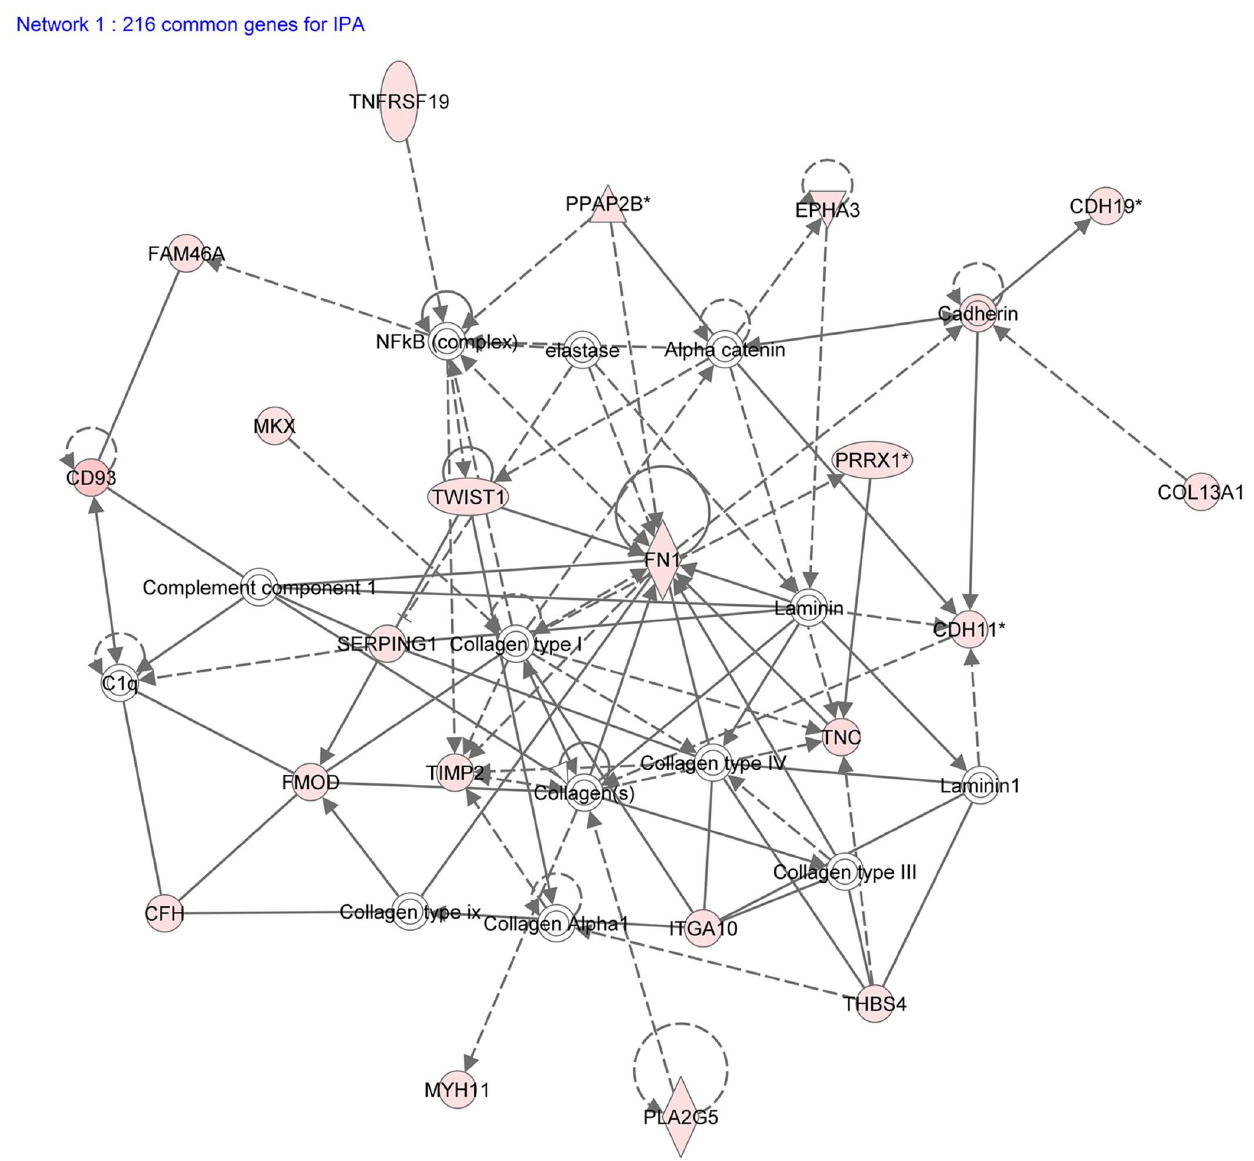
Figure 6. Network map of preferentially expressed signature limbal genes. The IPA network map highlights the upregulation of genes from the TGF- b pathway and extracellular matrix processes. Fibronectin-1 is centrally connected to a number of upregulated limbal genes.